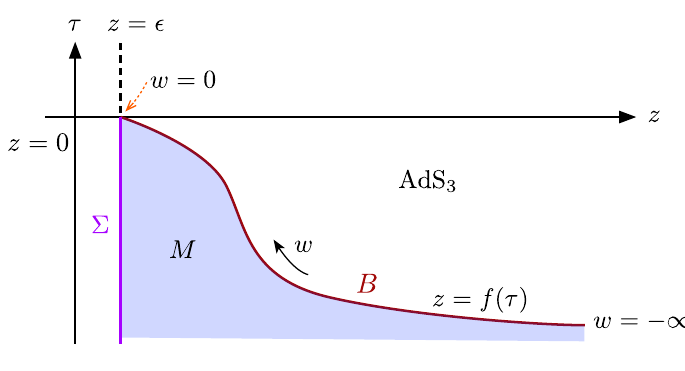
Figure 2 . Diagram of the geometric region M over which an evaluation of the gravitational action I G yields the computation of the Hartle-Hawking wavefunctional in AdS 3